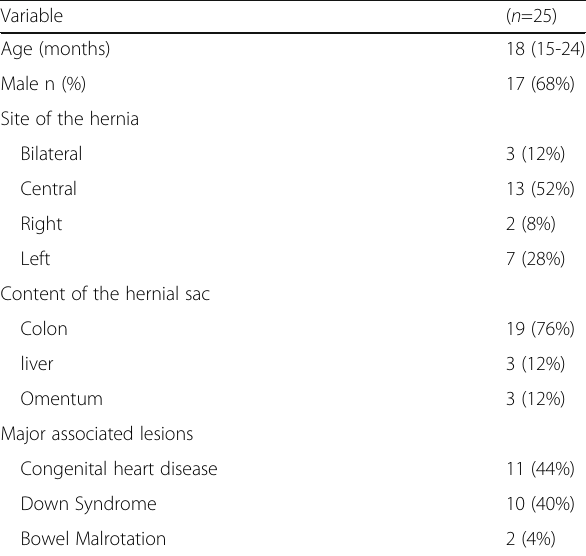
Table 1 Preoperative patients ’